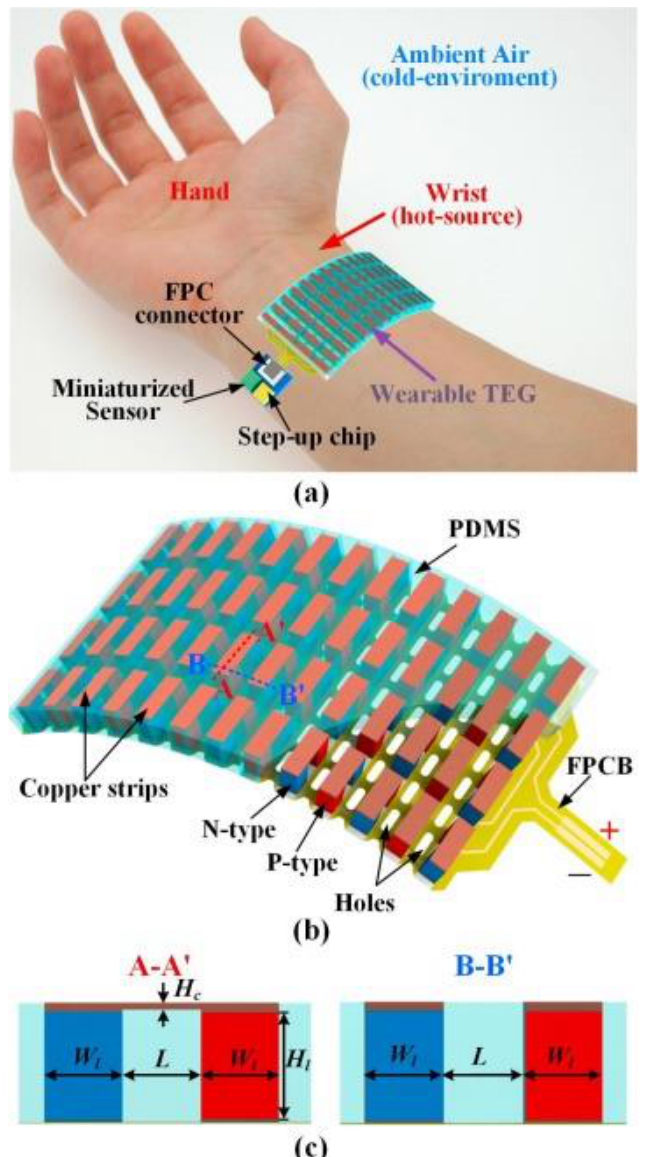
Figure 11. Schematic view of ( a ) TEG worn on the wrist to power the motion-monitoring sensor, ( b ) TEG construction, ( c ) cross-sections and structural parameters A-A ’ and B-B ’ ([63] license number: 5443011504464). Table 7. Comparison of thermoelectric harvesters.